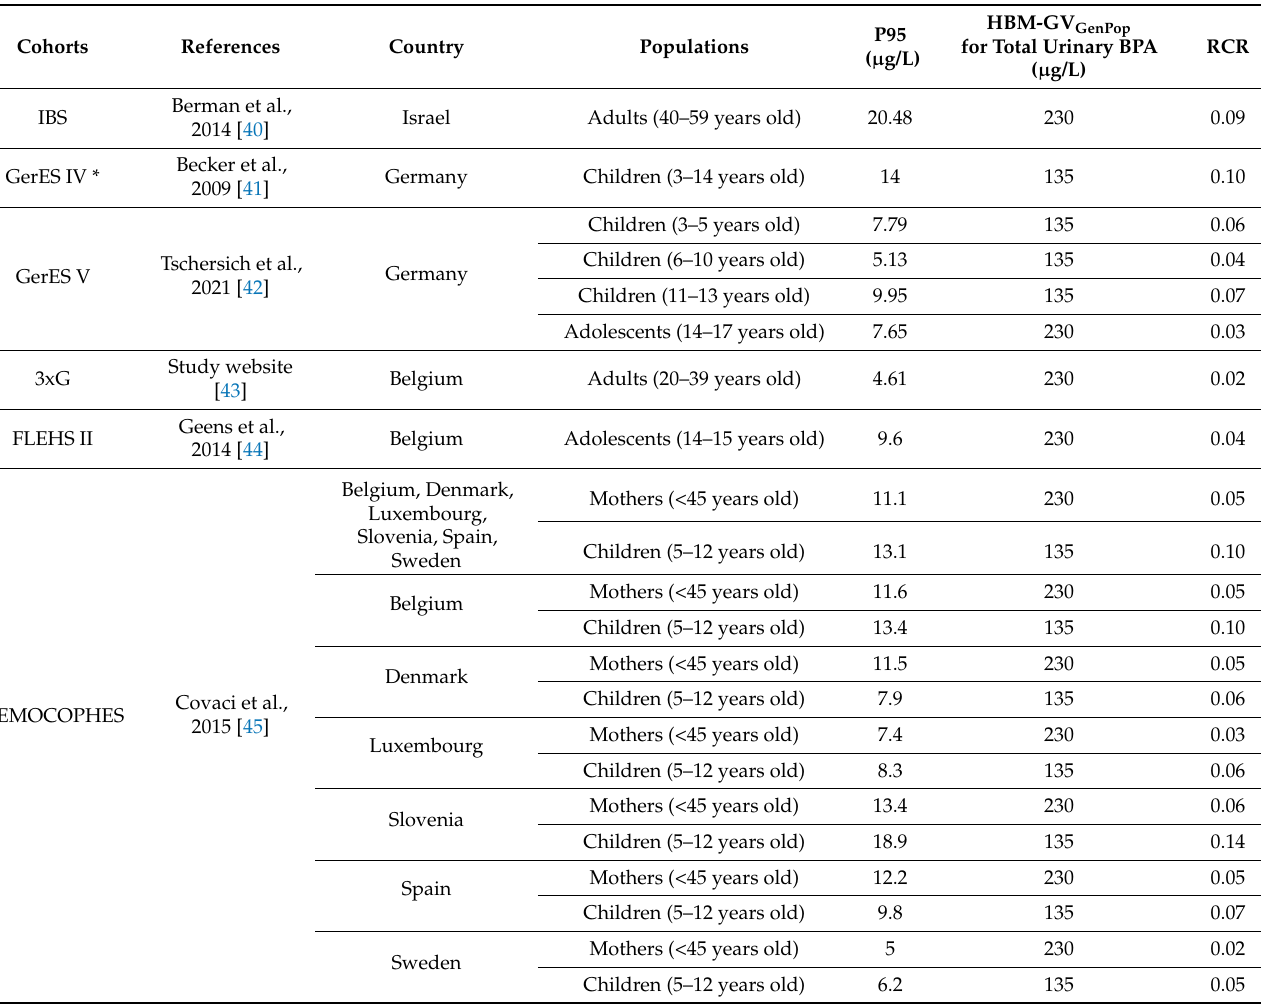
Table 2. Reported concentrations of total urinary BPA in the general population (P95) and RCR calculated using the HBM-GV GenPop recommended by